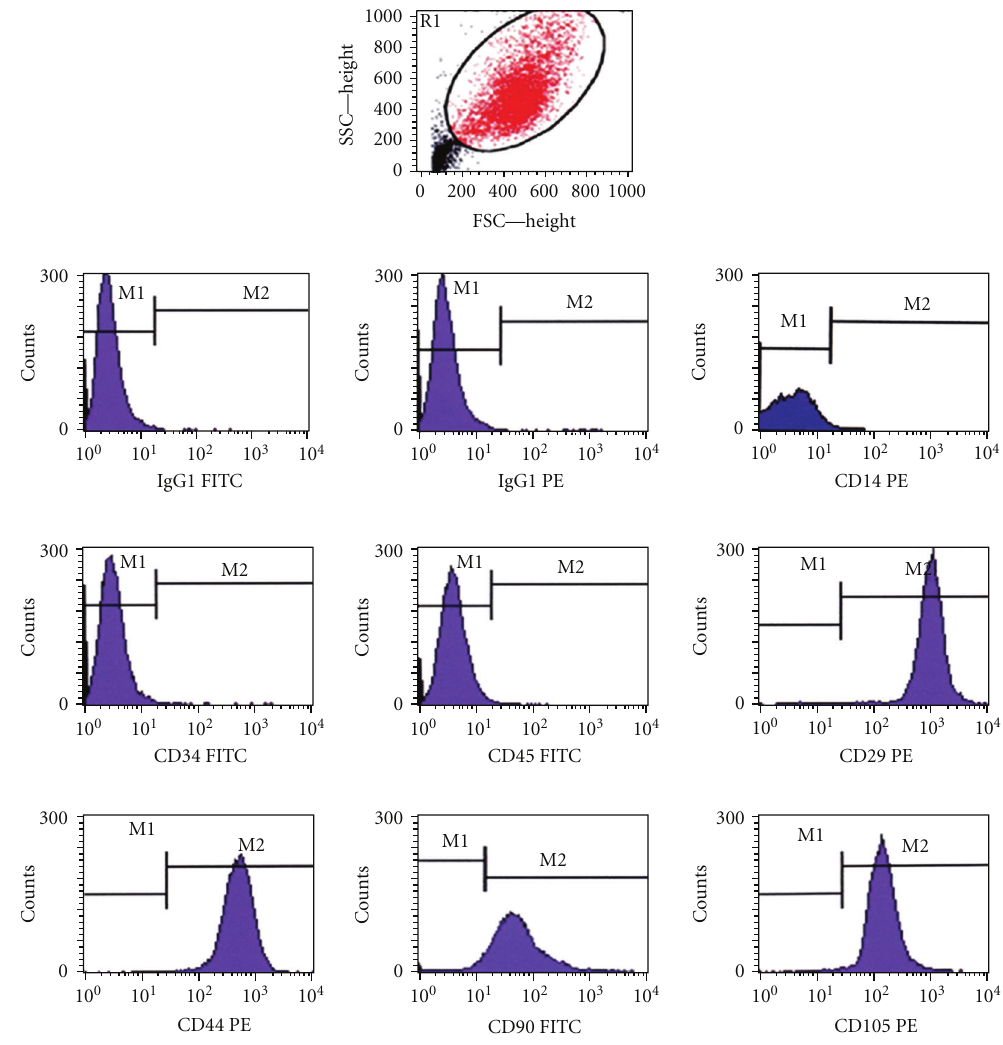
Figure 3: AFSCs membrane proteins were evaluated by flow cytometry with CellQuest software. Acquisitions were shown in histograms. AFSCs were positive for CD29 (98.27 ± 1.23%), CD44 (98.28 ± 1.65%), CD90 (97.69 ± 1.84%), CD105 (98.77 ± 0.64%) and were negative for CD14 (1.78 ± 1.06%), CD34 (1.70 ± 1.14%), and CD45 (1.80 ± 0.74%). IgG1-FITC and IgG1-PE antibodies were utilized as isotype controls. The number of acquired events was 20,000 in each